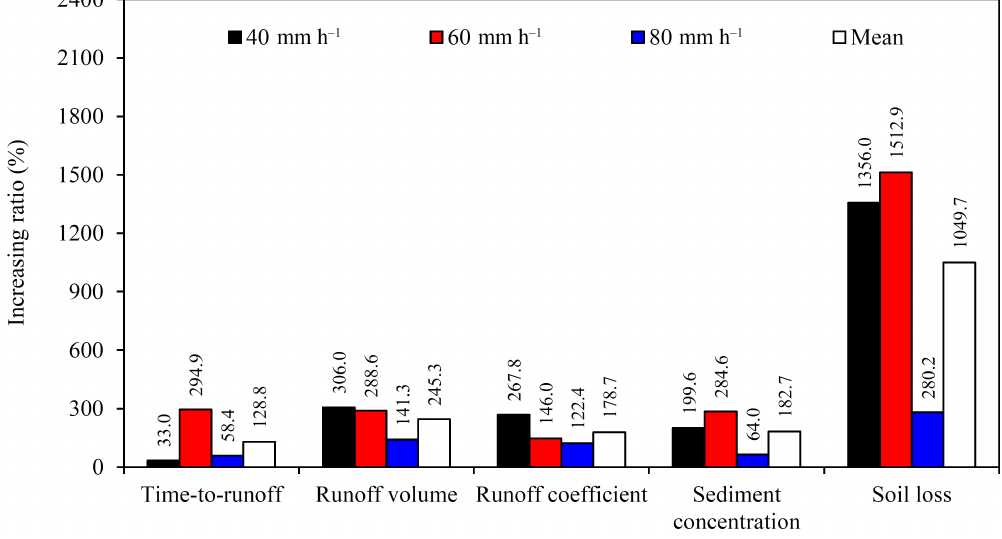
Figure 4. Increasing ratios of runoff variables, sediment concentration and soil loss after preparing soil. Table 1. The average time to runoff and runoff volume for three replicates of both before and after soil preparation treatments in three studied rainfall